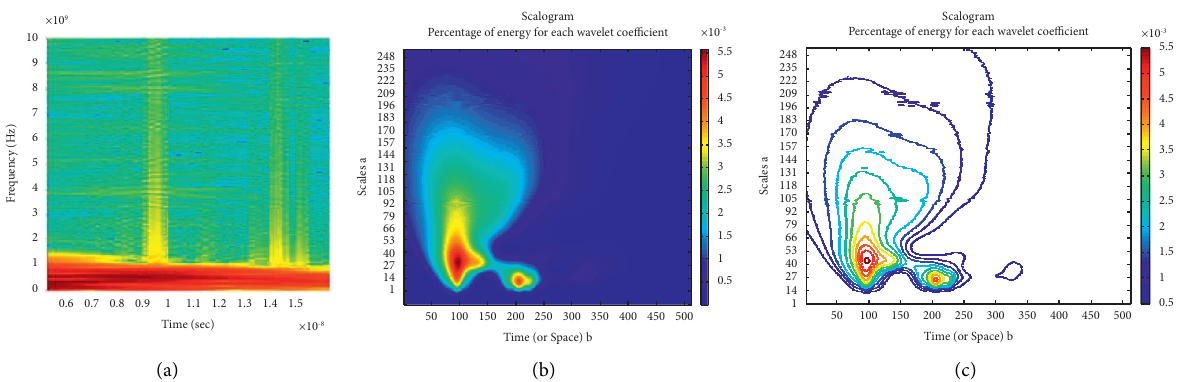
Figure 5: (a) Spectrogram of GPR signal of wet ballast. (b), (c) Wavelet spectrum of GPR signal of wet